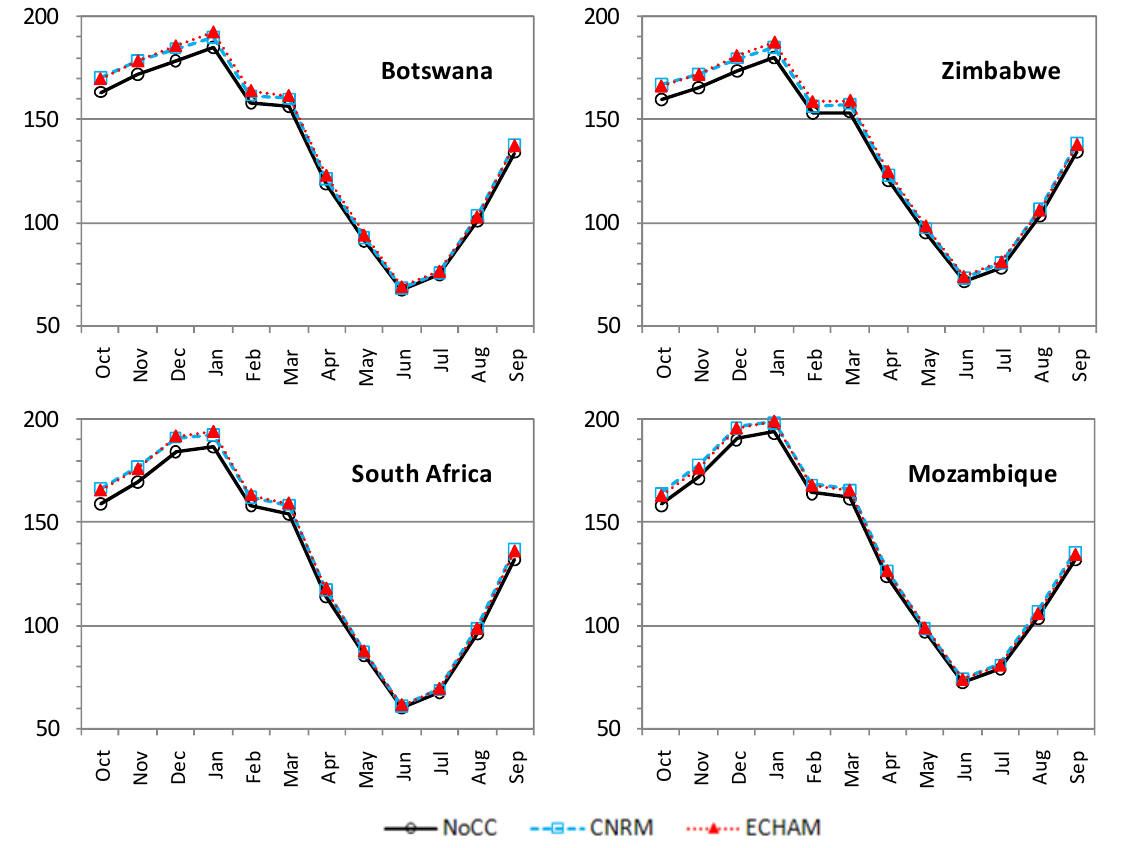
Figure 9. Mean monthly potential evapotranspiration (mm) under the 1971–2000 historical climate and climate change scenarios for 2050.